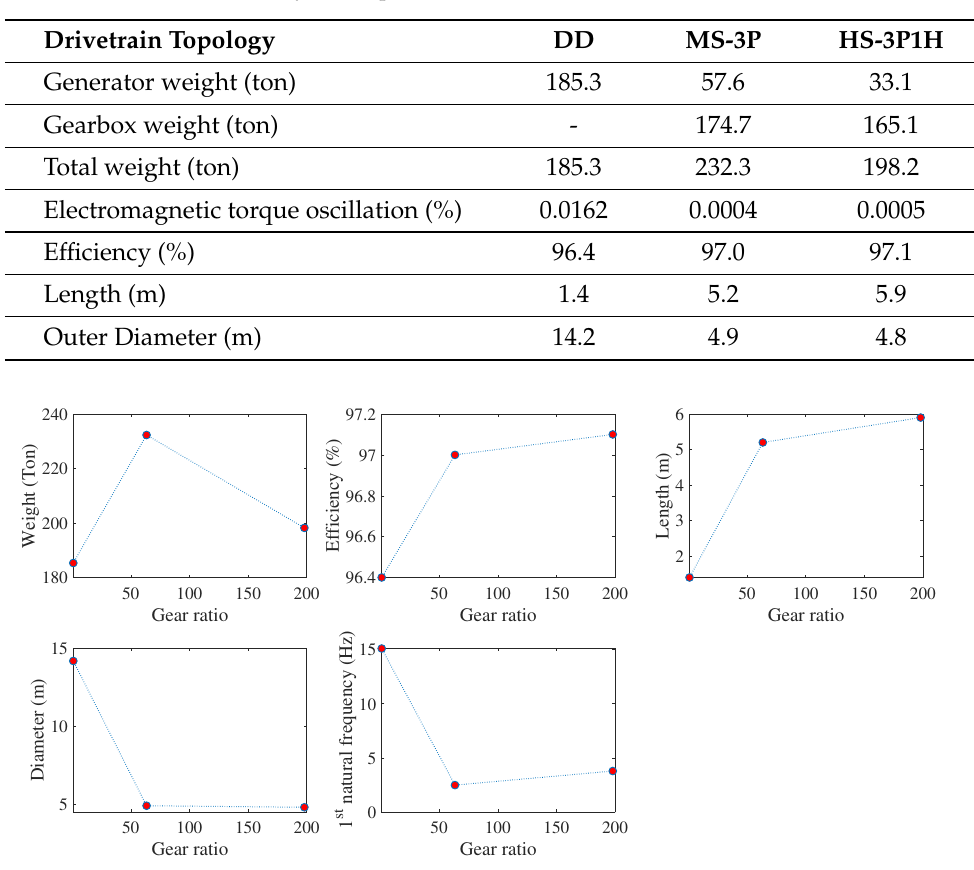
Table 10. Overall drivetrain systems specifications.